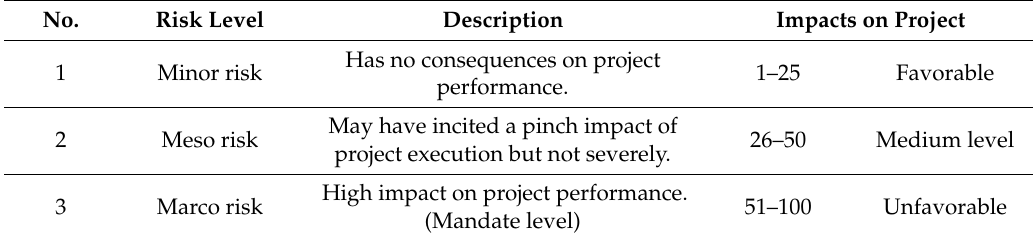
Table 1. Three impact levels of project